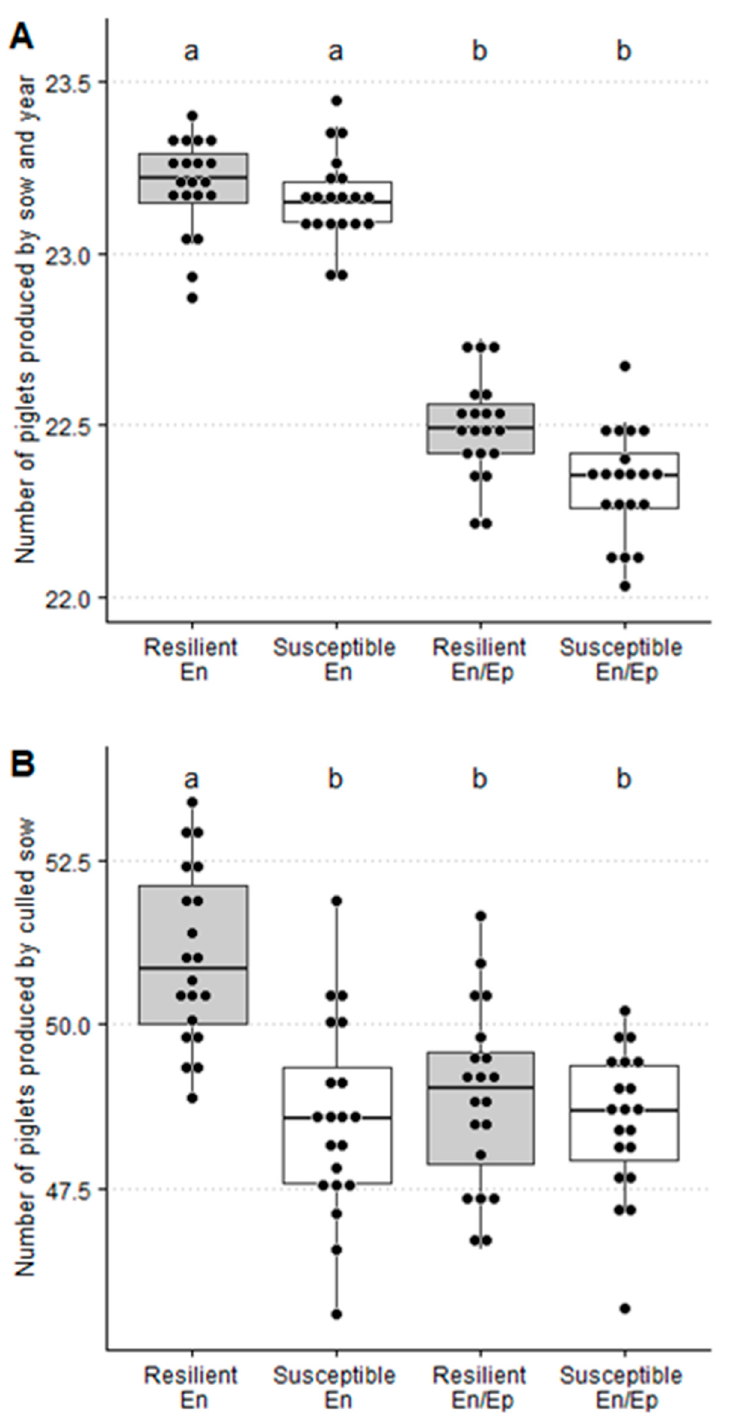
Figure 3. Number of piglets produced by sow and year ( A ), and the number of piglets produced by culled sow ( B ) for porcine reproductive and respiratory syndrome (PRRSV) resilient and susceptible sows in a PRRSV endemic-infected farm not suffering (En) or experiencing (En/Ep) one epidemic PRRSV outbreak with an average duration of 24 weeks within three years. Bars with different superscripts showed statistically significant differences ( p <